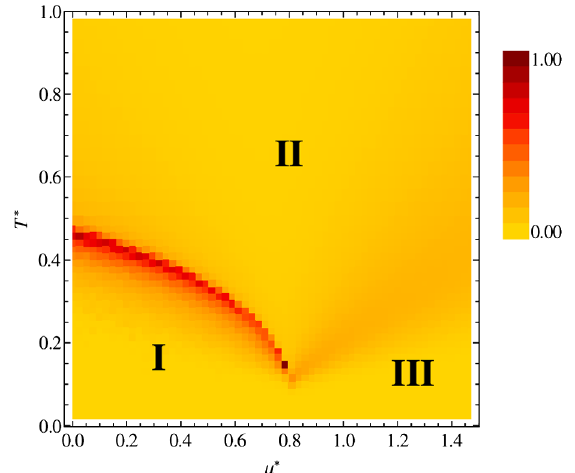
FIG. 3. The position of the singularity in the specific heat C (cid:2) in the ð (cid:2) (cid:4) ; T (cid:4) Þ plane traces out the phase boundary for the monopole-crystal phase. The most intense peak signals the passage of the transition from second to first order via a tricritical point. Indexes I, II, and III mark the monopole crystal, high- density fluid, and low-density fluids, respectively. Regions II and III are separated by a continuous crossover, and the gas of monopoles (III) corresponds to the low-temperature phase for spin ice.